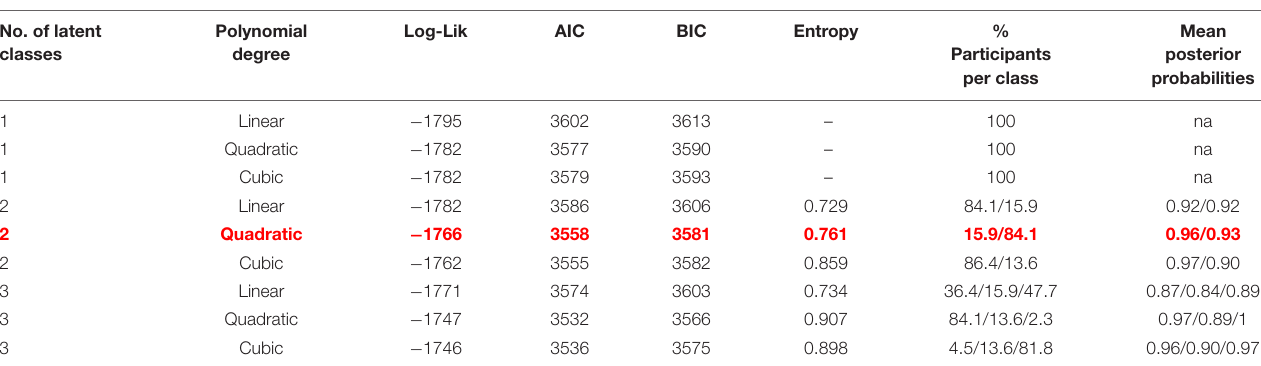
TABLE 4 | Latent class mixed models (lcmm) results of model fitting process for